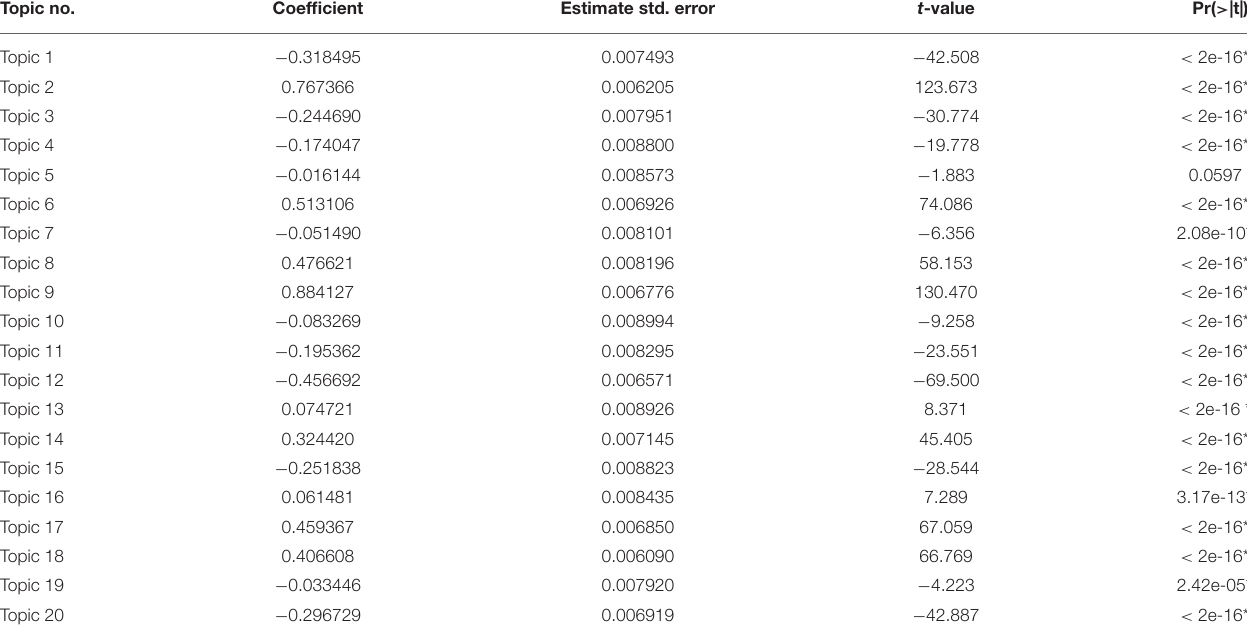
TABLE 5 | sLDA statistical